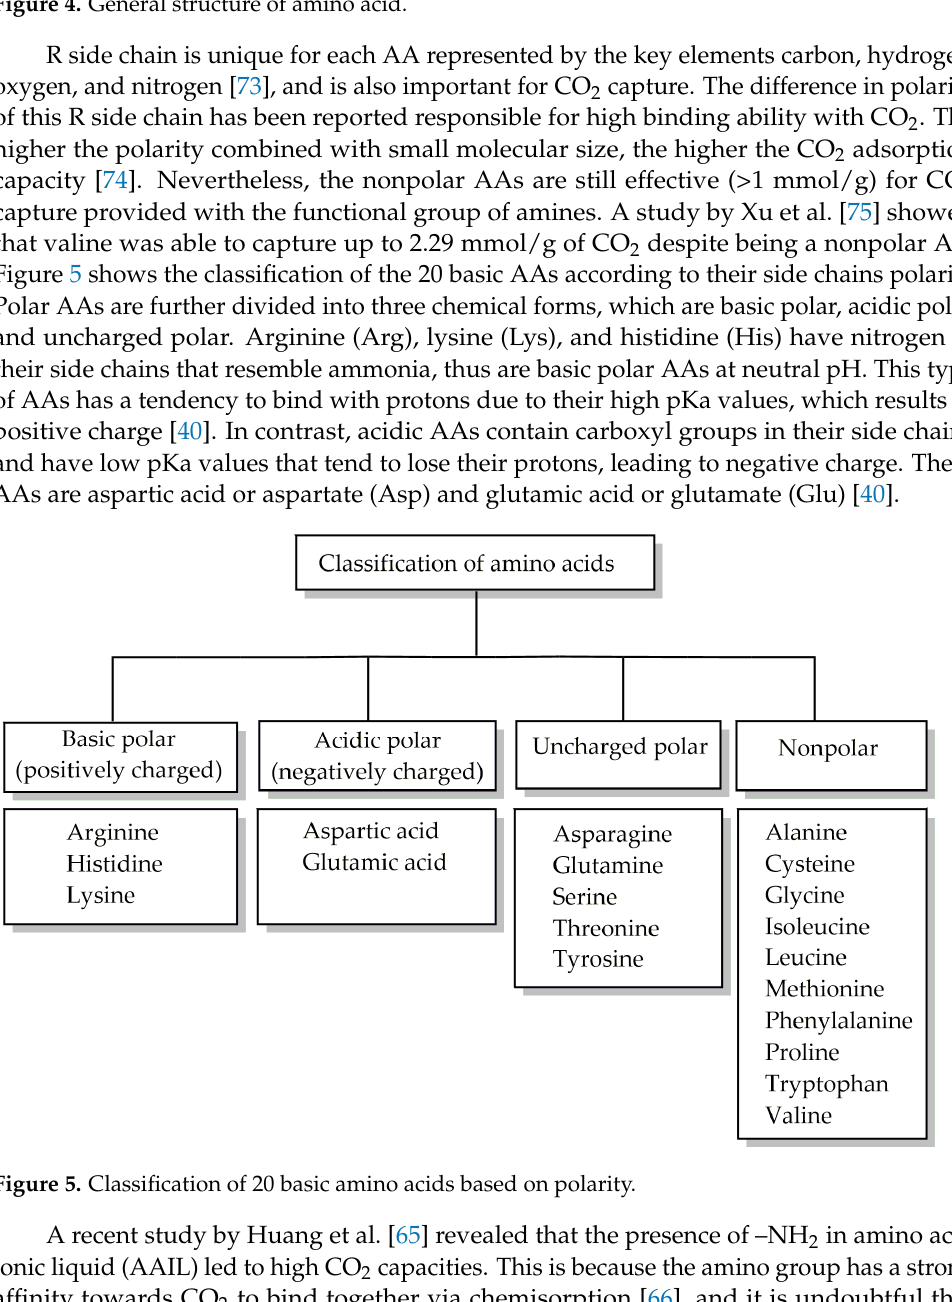
Figure 4. General structure of amino acid.